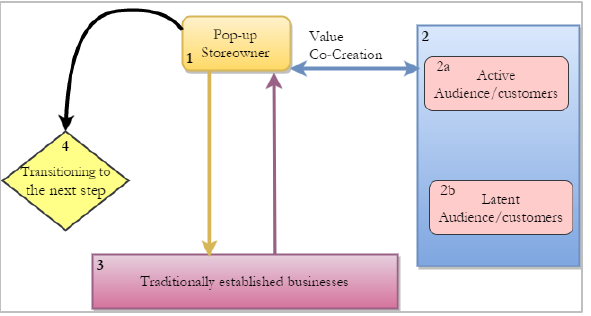
Figure 7. Value creation and co-creation interactions (virtual pop-up stores).